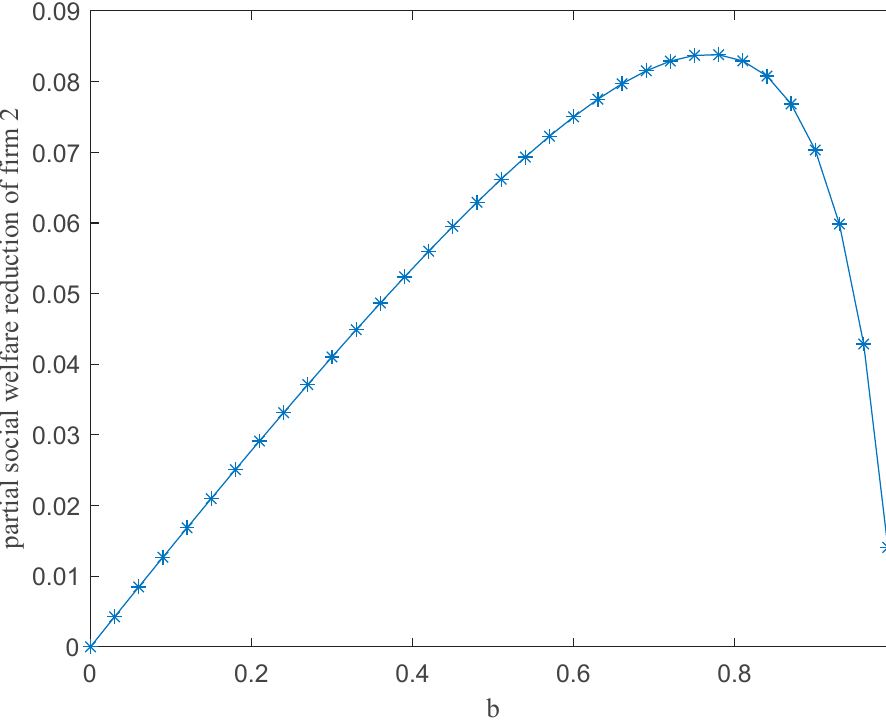
Figure 8. The reduction effect of the local social welfare of firm 2.